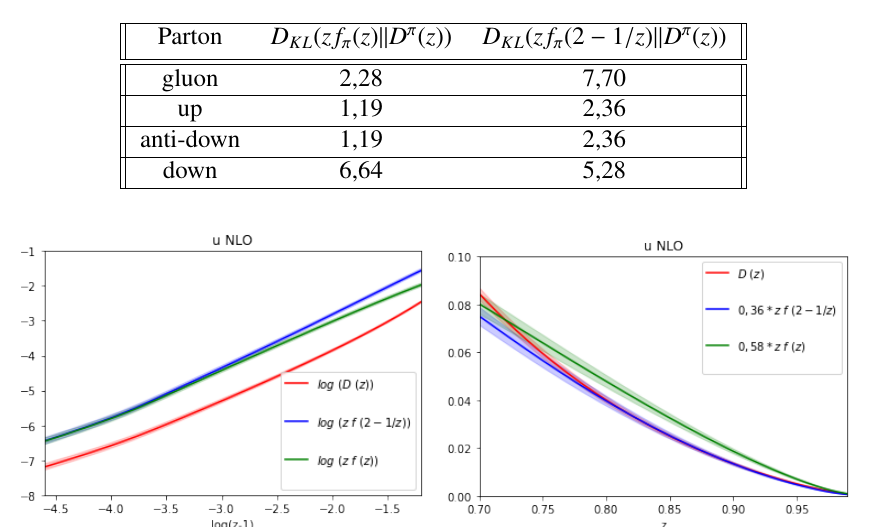
Table 2. Values of the Kullback-Leibler divergence between the parton distribution function with argument 2 − 1 / z as in Eq. (6), or with the further simplified 2 − 1 / z → z , to the fragmentation function. (We have employed the NLO parametrizations of JAM coll. for π + fragmentation at scale